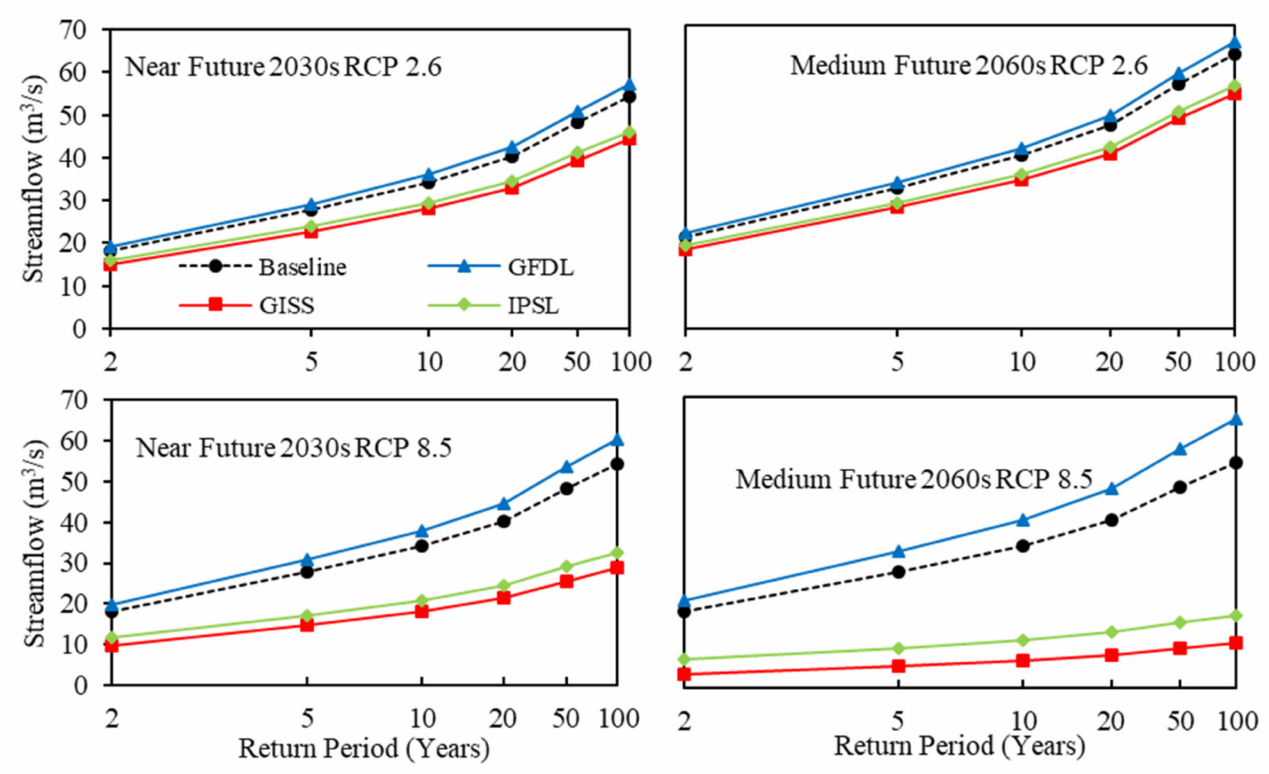
Figure 8. One-day minimum flow frequency